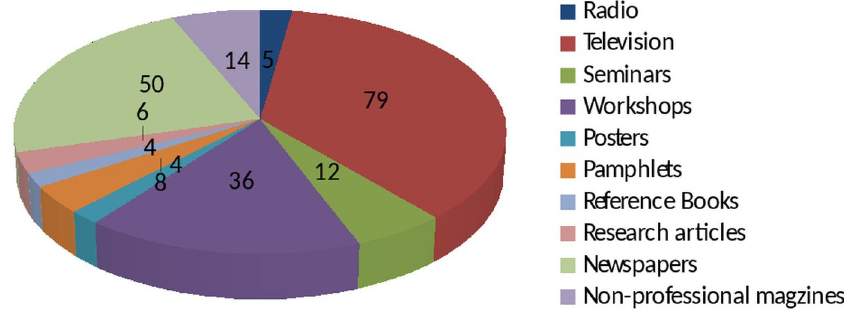
Fig 1. Sources of JE information reported by